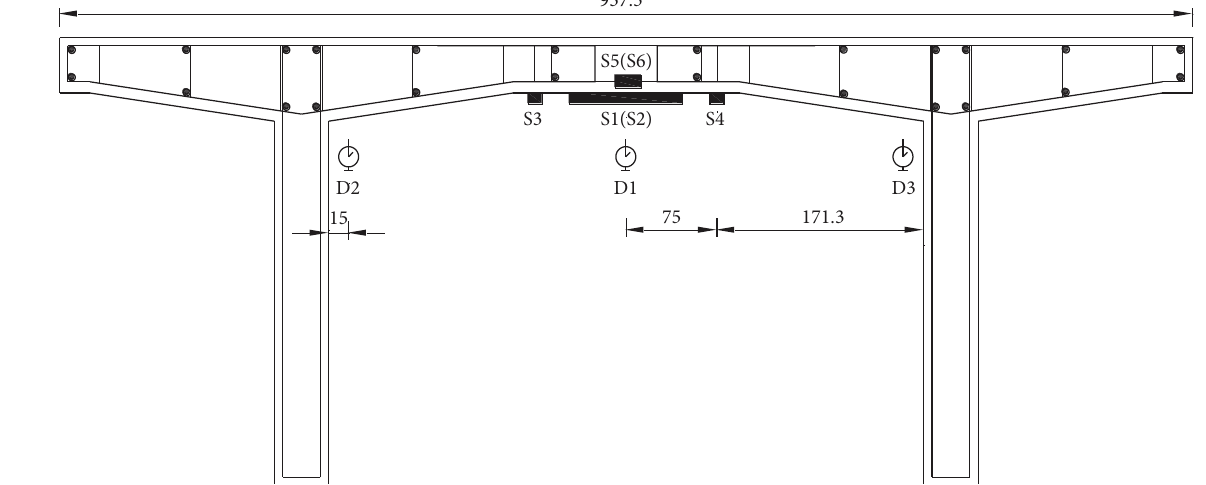
Figure 4: Layout drawing of measuring points across the interrupted surface.